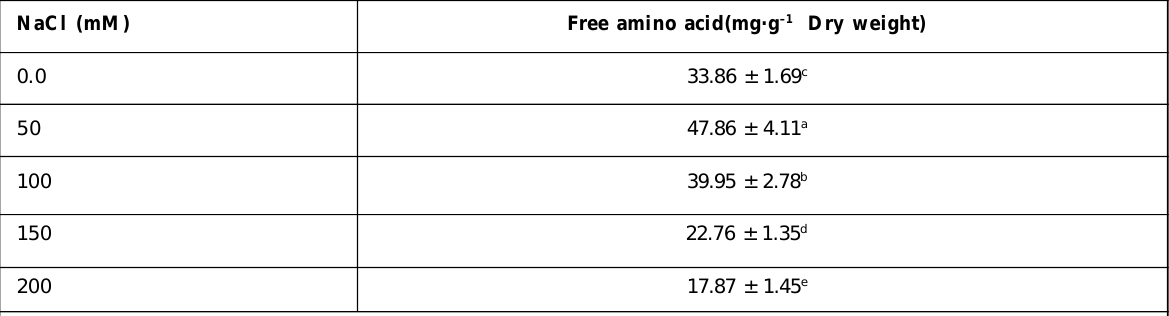
Table 7: Impact of different concentrations of NaCl on free amino acid in Phaseolus vulgaris L. NaCl